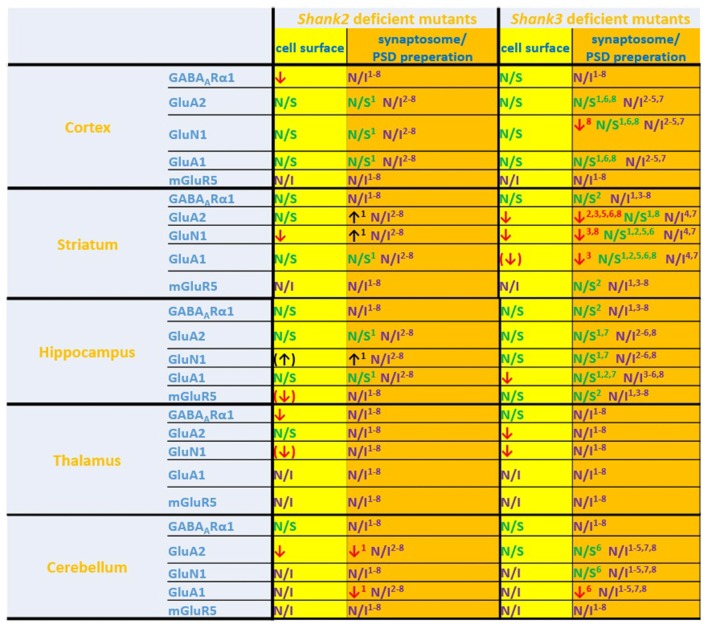
Comparison of cell surface glutamate receptor subunit analysis with synaptosome/postsynaptic density (PSD) preparation analysis of glutamate receptors in ASD related brain regions in Shank2 and Shank3 deficient mice. Cell surface glutamate receptor subunit analysis and synaptosome/PSD preparation analysis reveals that the results of both methods do not necessarily show similar trends but both approaches usually generate converging data. 1Refers to data from Schmeisser et al. (2012). 2Refers to data from Peca et al. (2011). 3Refers to data from Reim et al. (2017). 4Refers to data from Peter et al. (2016). 5Refers to data from Jaramillo et al. (2016). 6Refers to data from Mei et al. (2016). 7Refers to data from Kouser et al. (2013). 8Refers to data from Zhou et al. (2016); note that in this study two different and Shank3 deficient mice were analyzed. Cell surface refers to data from the current work: ↓ p < 0.05; (↓), (↑) p < 0.10. N/I stands for not investigated and N/S stands for non-significant results. Figure only shows data from brain regions/antibody detections which were addressed in this study. Upregulated ↑; downregulated ↓.